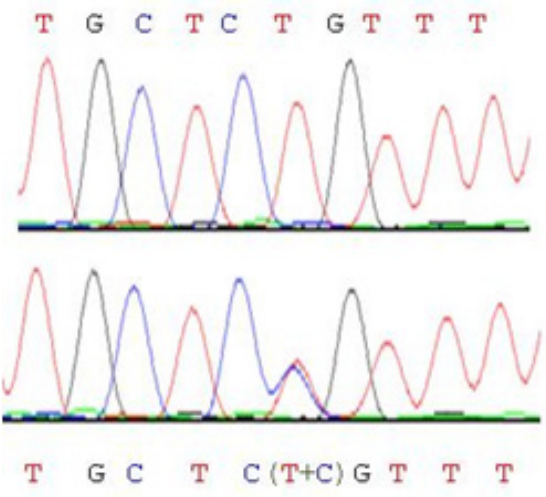
Figure 2: Sequencing profile of a DNA. Legend: variation heterozygous change at the 6th base pair